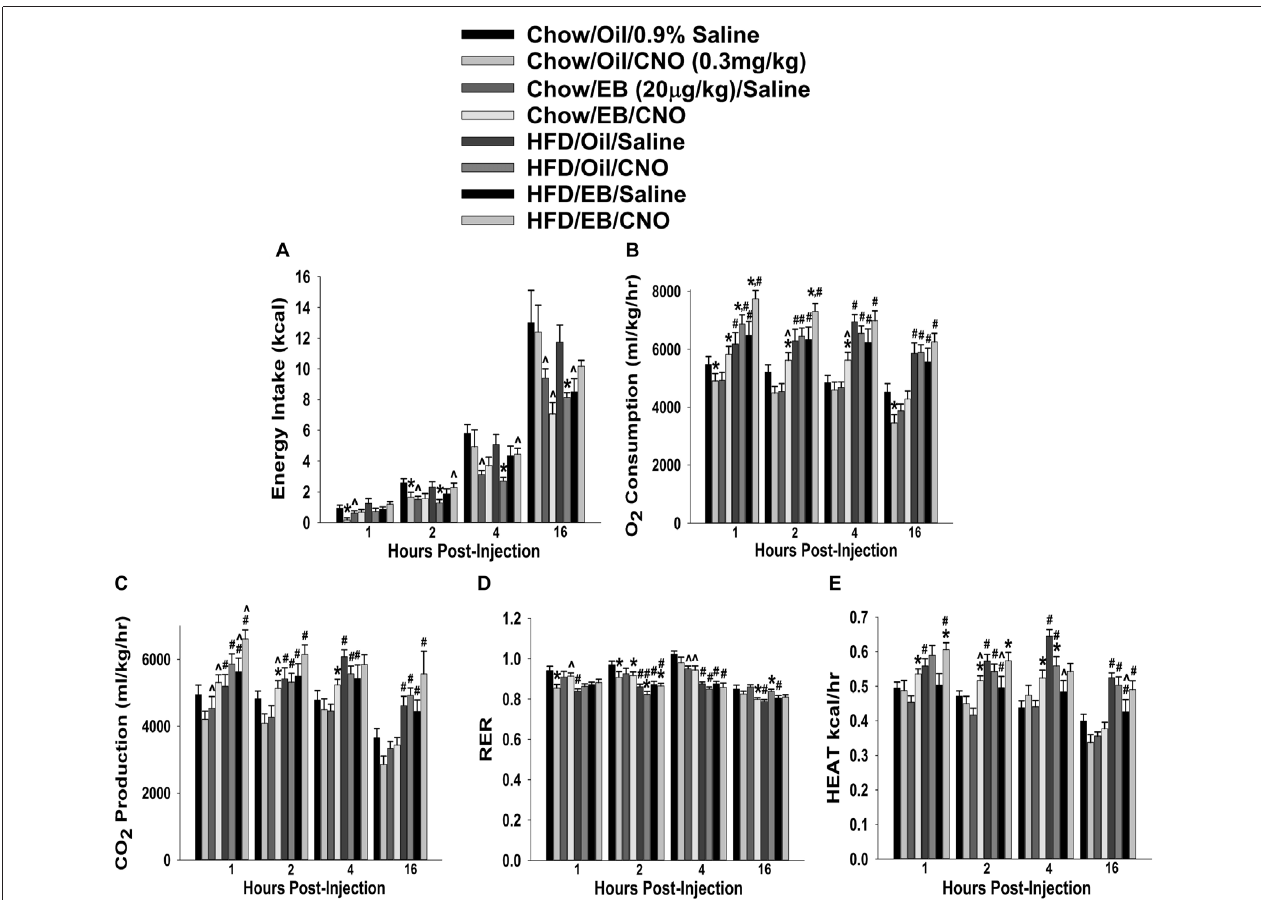
FIGURE 12 | Chemostimulation of VMN SF-1 neurons in ovariectomized NR5A1-cre mice alters cumulative energy intake (A) , O 2 consumption (B) , CO 2 production (C) , RER (D) and metabolic heat production (E) in an EB- and diet-sensitive manner. CNO (0.3 mg/kg) significantly decreased energy intake in chow-fed oil-treated animals, and to a larger extent in HFD-fed animals. It also increased energy expenditure in chow- and HFD-fed, EB-treated animals. Bars represent means and lines 1 SEM of the cumulative food intake, O 2 consumption, CO 2 production, and RER seen in chow- and HFD-fed NR5A1-Cre mice treated with either CNO (0.3 mg/kg; oil/chow: n = 5; oil/HFD: n = 6; EB/chow: n = 6; EB/HFD: n = 5), or its filtered 0.9% saline vehicle (oil/chow: n = 8; oil/HFD: n = 6; EB/chow: n = 6; EB/HFD: n = 6). ∗ P < 0.05 relative to saline-treated animals; multifactorial ANOVA/LSD; n = 5–8. # P < 0.05 relative to chow-fed animals; multifactorial ANOVA/LSD; n =